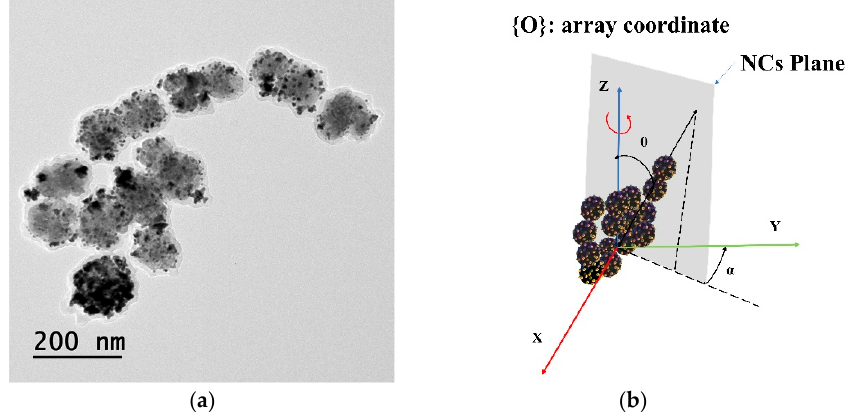
Figure 7. Characteristic of NCs: ( a ) TEM image of NCs; ( b ) The plane of NCs in the {O} coordinate system.